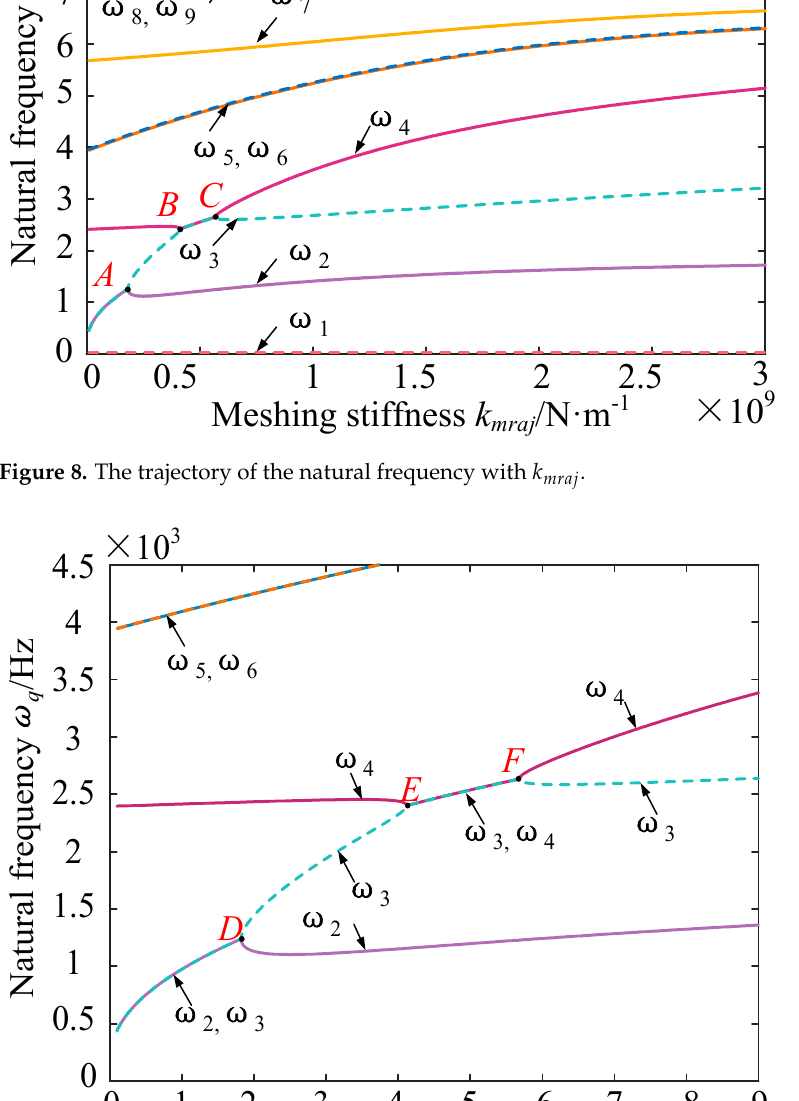
. . . (cid:3040)(cid:3046)(cid:3028)(cid:3037) . (cid:3040)(cid:3046)(cid:3028)(cid:3037)